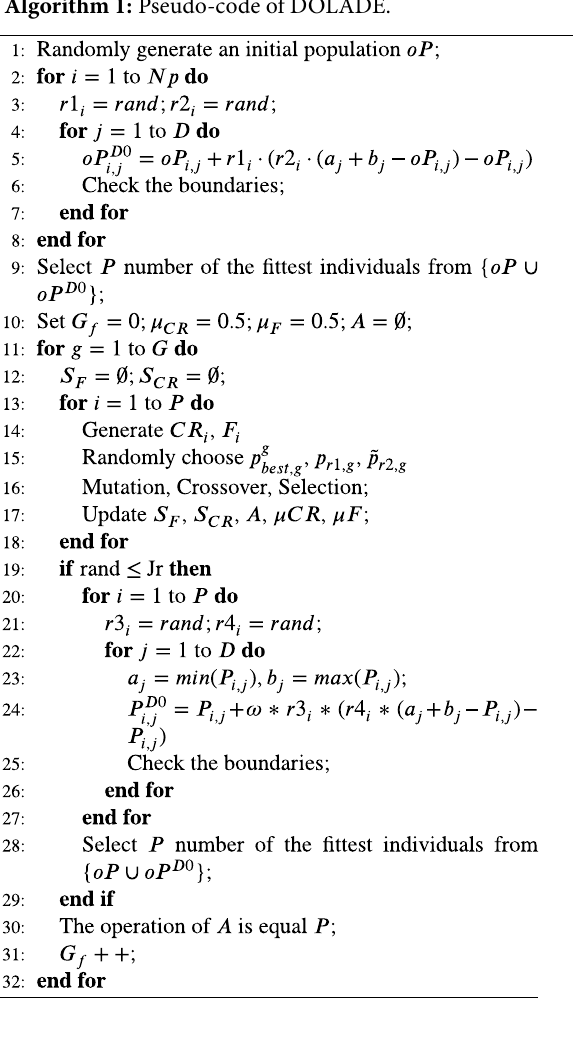
Algorithm 1: Pseudo-code of DOLADE.